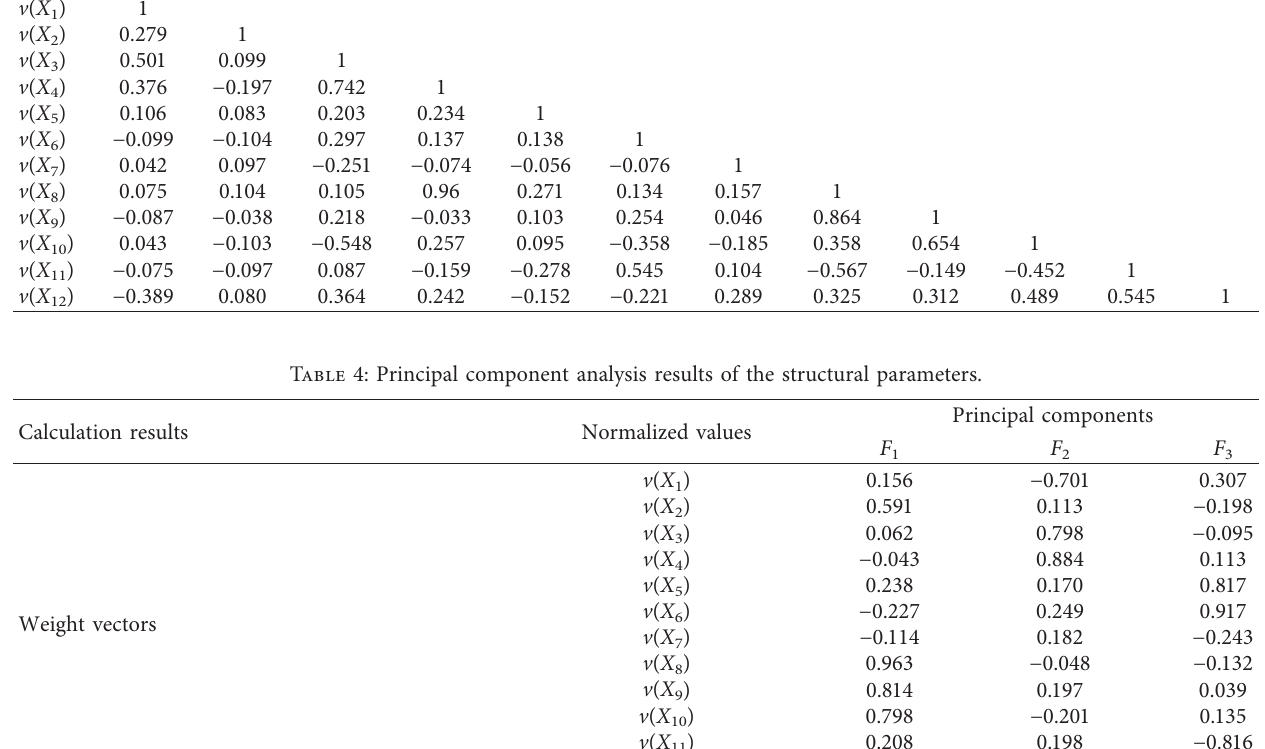
Table 3: Correlation coefficient matrix ρ